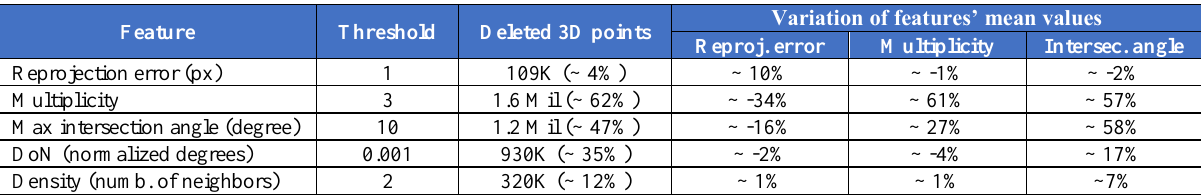
Table 2: Variation of the employed quality features when filtering is performed using a single feature. For each feature, the filtering threshold, the number of removed 3D tie points and the variation of the quality features after the points removal are shown. Negative variations represent an improvement only in the reprojection error